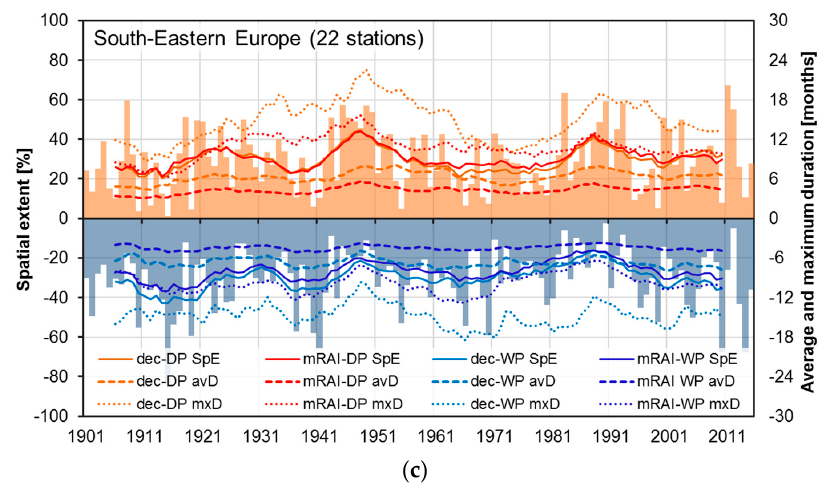
Figure A5. Time series (annual resolution; 11-year low pass filtered data) of spatial extent (SpE; bars for decile index) as well as average (avD) and maximum duration (mxD) of dry (DP)and wet periods (WP) as indicated by the deciles index (dec; orange and light blue) and the mRAI (red and intense blue) for the sub-regions ( a ) IP, ( b ) MR, and ( c ) SE for period 1901–2015. For illustration purposes, the WP results are printed as negative values.